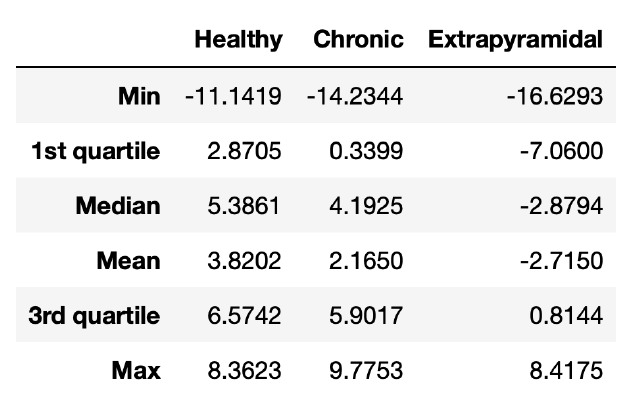
Figure 7. Main statistics for the three classes of patients.